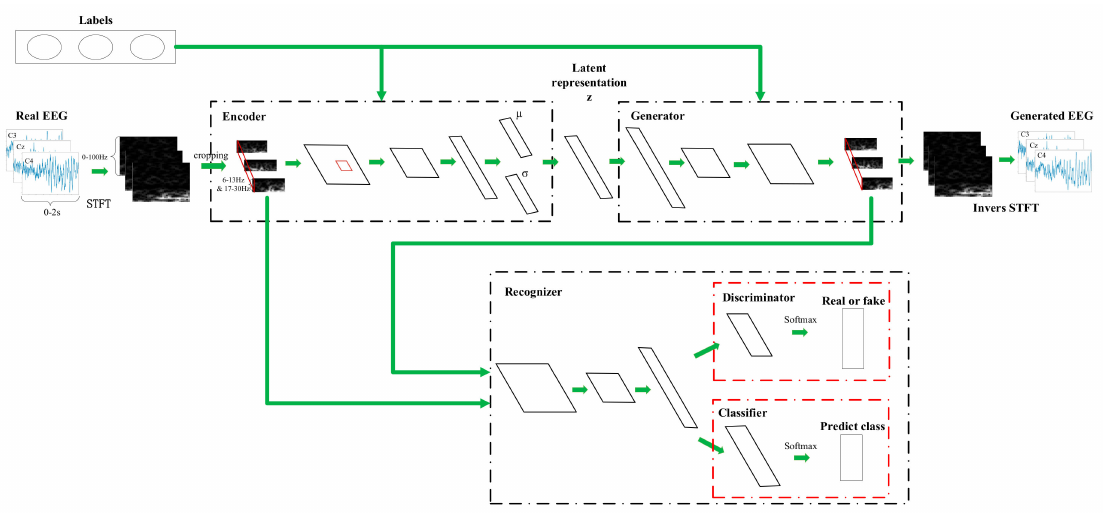
Figure 2. The proposed CVAE-GAN architecture for synthetic EEG